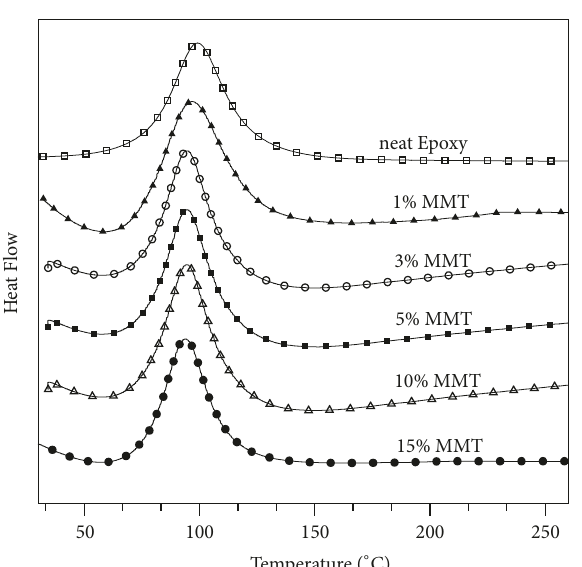
Figure5: DSCcurvesof0,1,3,5,10,and15%WeightofMMT-epoxy nanocomposites.